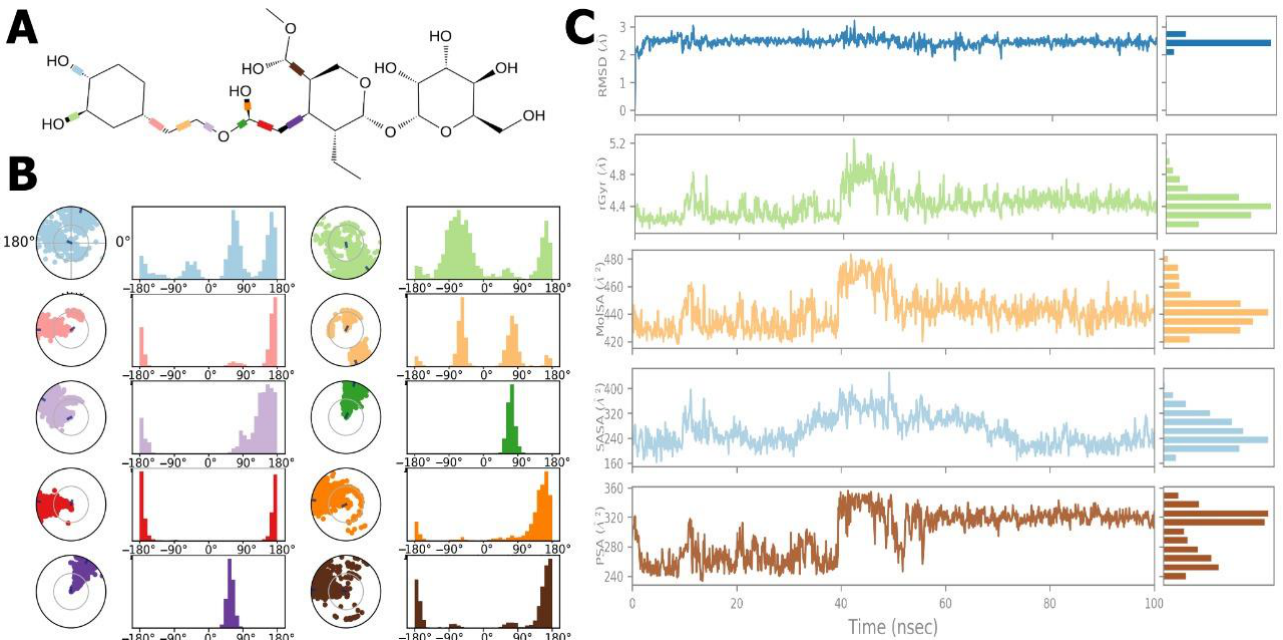
Figure 12. Ligand torsion profile: ( A ) torsion and flexibility, ( B ) ligand torsion angles, and ( C ) ligand (oleuropein) property trajectory of the ligand- EFLec complex. The ligand properties fluctuated during the beginning or intermediate simulation periods, but gradually returned to equilibrium during 100 ns of simulation, indicating that ligand was stable at the active site of the protein.